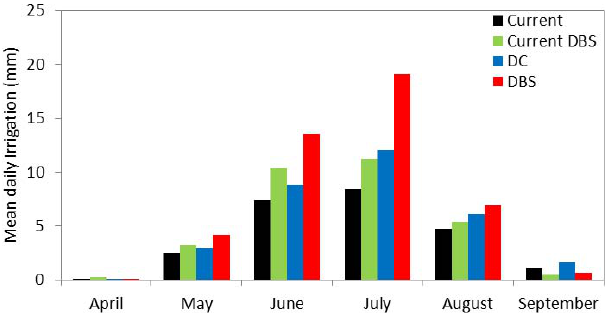
Fig. 9. Distribution of irrigation in the irrigation